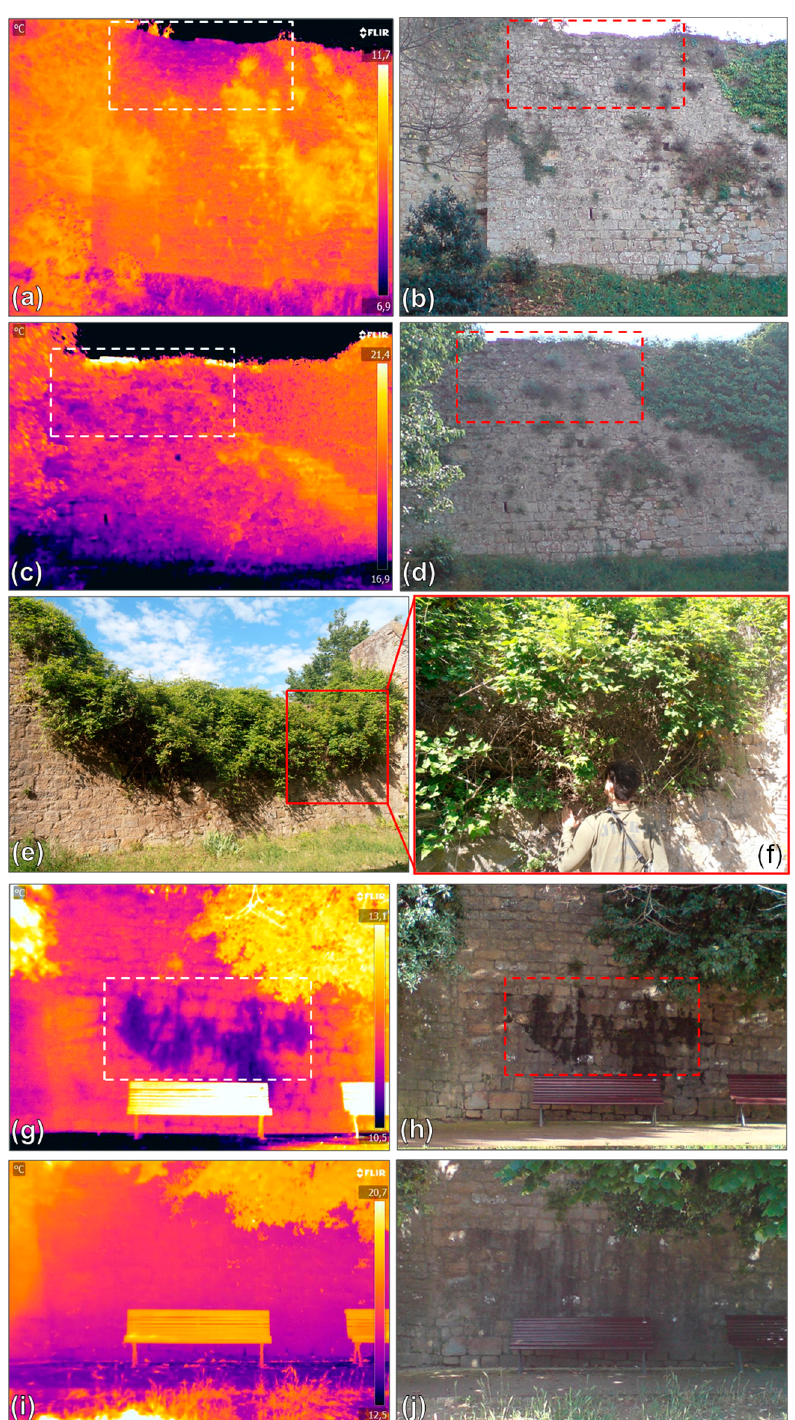
Figure 10. ( a ) Mosaicked thermogram of the northern wall sector ( Viale Francesco Ferrucci , label 2 in Figure 9a), acquired on 2 December 2014 and correspondent photo ( b ) (dashed white and red squares enhance the sectors where a cold thermal anomaly was detected); ( c ) Mosaicked thermogram acquired in the same sector during the 25 May 2015 survey and correspondent photo ( d ); ( e , f ) Views of the back portion of the investigated wall shown in Figure 10a–d; ( g ) single thermogram of western city wall sector ( Viale Trento e Trieste , label 1 in Figure 9a) acquired on 2 December 2015 and correspondent photo ( h ) (dashed squares enhance the detected cold thermal anomalies); ( i ) single thermogram acquired in the same sector on 25 May 2015 and correspondent photo ( j ).